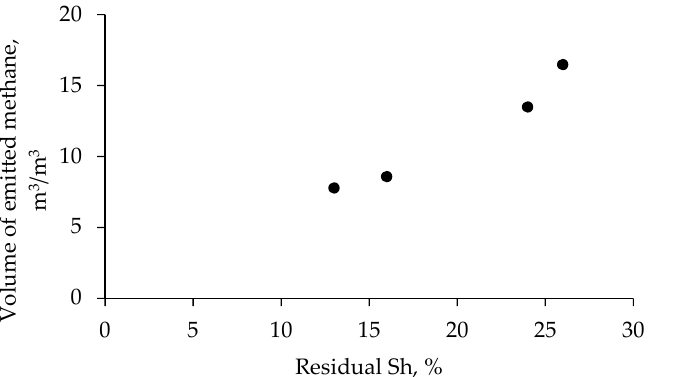
Figure 15. Methane emission upon the temperature increase in frozen hydrate-bearing sand 3 as a function of residual hydrate saturation.